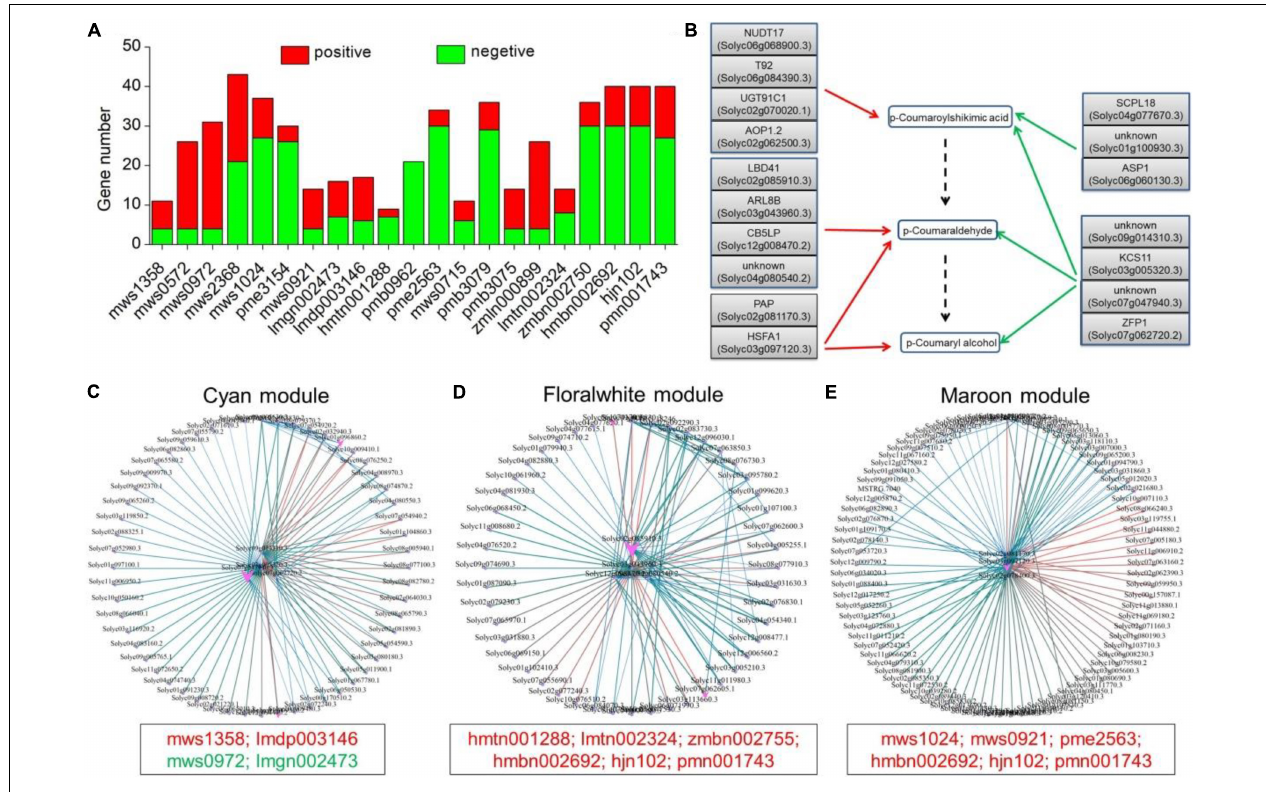
FIGURE 11 | Key candidate genes and gene networks involved in part of the metabolites as identified by WGCNA. (A) Statistics of key candidate genes of metabolites with more than 10-fold change. (B) Key candidate genes involved in the regulation of p-Coumaroylshikimic acid, p-Coumaraldehyde, and p-Coumaryl alcohol. Red and green arrows represent positive and negative correlations, respectively. The dashed arrow represents the predicted metabolic pathway. (C) Gene network for the cyan module, which positively correlated with mws1358 ( γ 2 = 0.97), lmdp003146 ( γ 2 = 0.81), and negatively with mws0972 ( γ 2 = –0.86), lmgn002473 ( γ 2 = –0.89). (D) Gene network for the floralwhite module, which positively correlated with hmtn001288 ( γ 2 = 0.97), lmtn002324 ( γ 2 = 0.95), zmbn002750 ( γ 2 = 0.95), hmbn002692 ( γ 2 = 0.9), hjn102 ( γ 2 = 0.9), and pmn001743 ( γ 2 = 0.87). (E) Gene network for the maroon module, which positively correlated with mws1024 ( γ 2 = 0.91), mws0921 ( γ 2 = 0.91), pme2563 ( γ 2 = 0.94), hmbn002692 ( γ 2 = 0.87), hjn102 ( γ 2 = 0.88), and pmn001743 ( γ 2 =